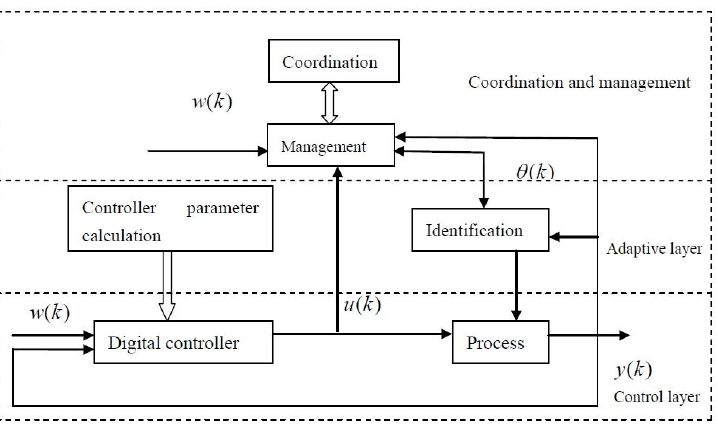
Figure 5. Architecture of adaptive control system.